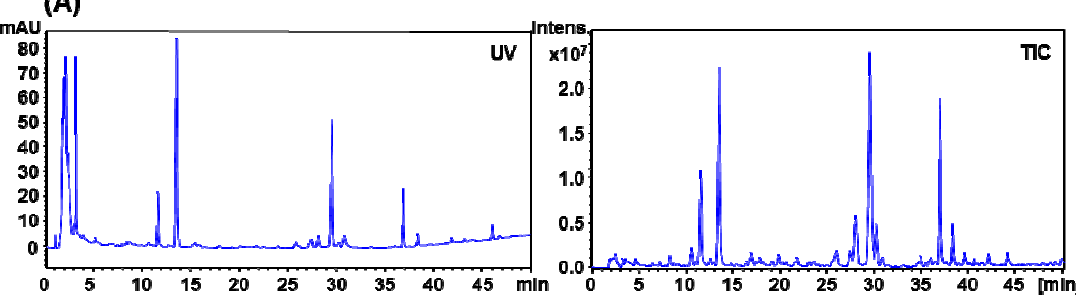
Figure 5. Representative HPLC-UV and MS chromatograms of different parts of P. notoginseng . ( A ) underground parts, ( B ) seed, ( C ) stem, ( D ) leaf and ( E ) flower, of P. notoginseng . UV, detected at the 203 nm; TIC, detected in negative ionization